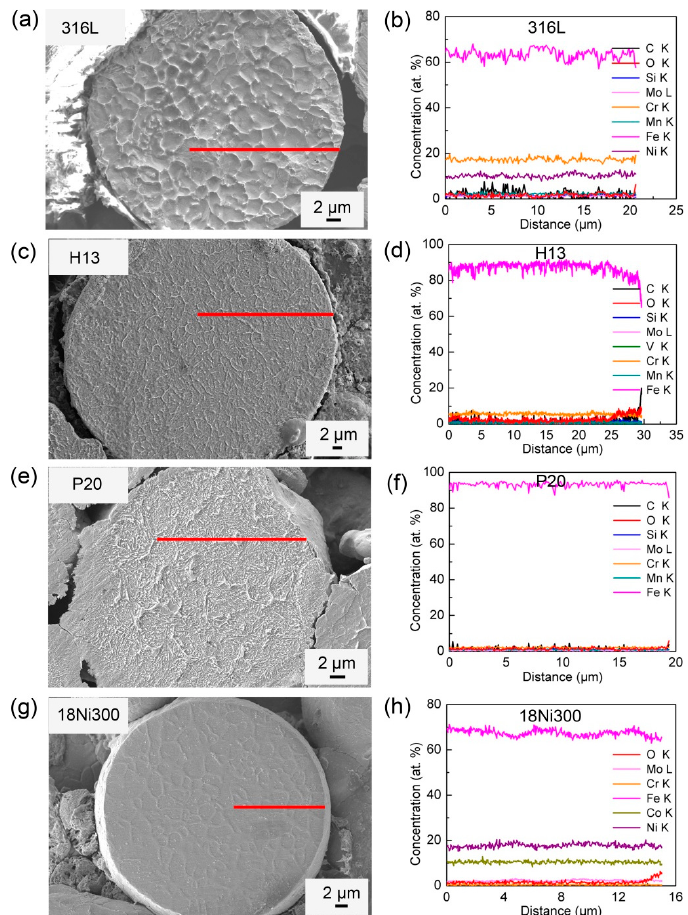
Figure 3. SEM-SE images of the cross sections of ( a ) 316L, ( c ) H13, ( e ) P20 and ( g ) 18Ni300 powders and energy dispersive X-ray spectroscopy (EDX) line scanning of the area marked by red dashed line shown in the left images.